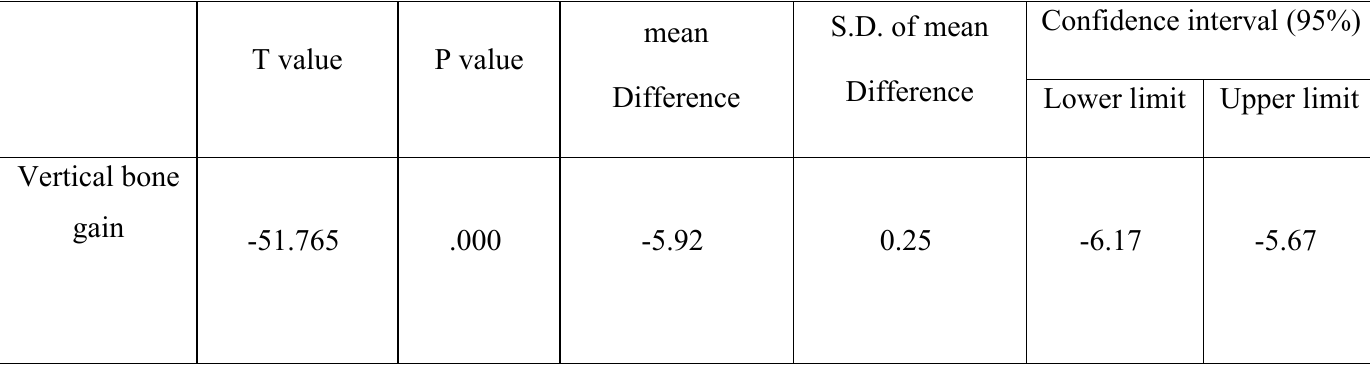
Table 5: Paired T test for samples to study the change in the height of the alveolar bone before and after 3 months of the distraction osteogenesis